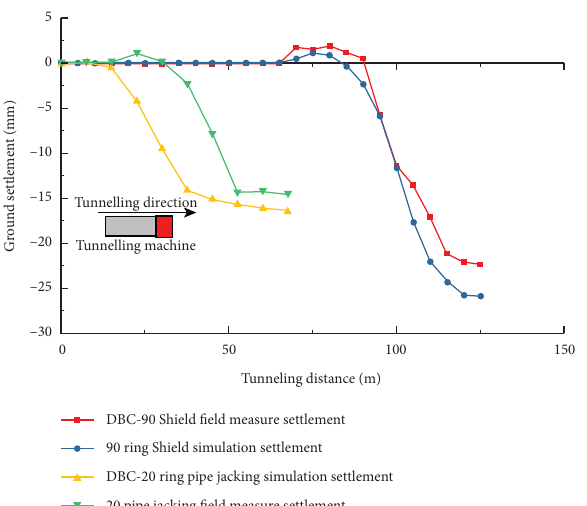
Figure 13: Longitudinal ground surface settlement of shield and pipe